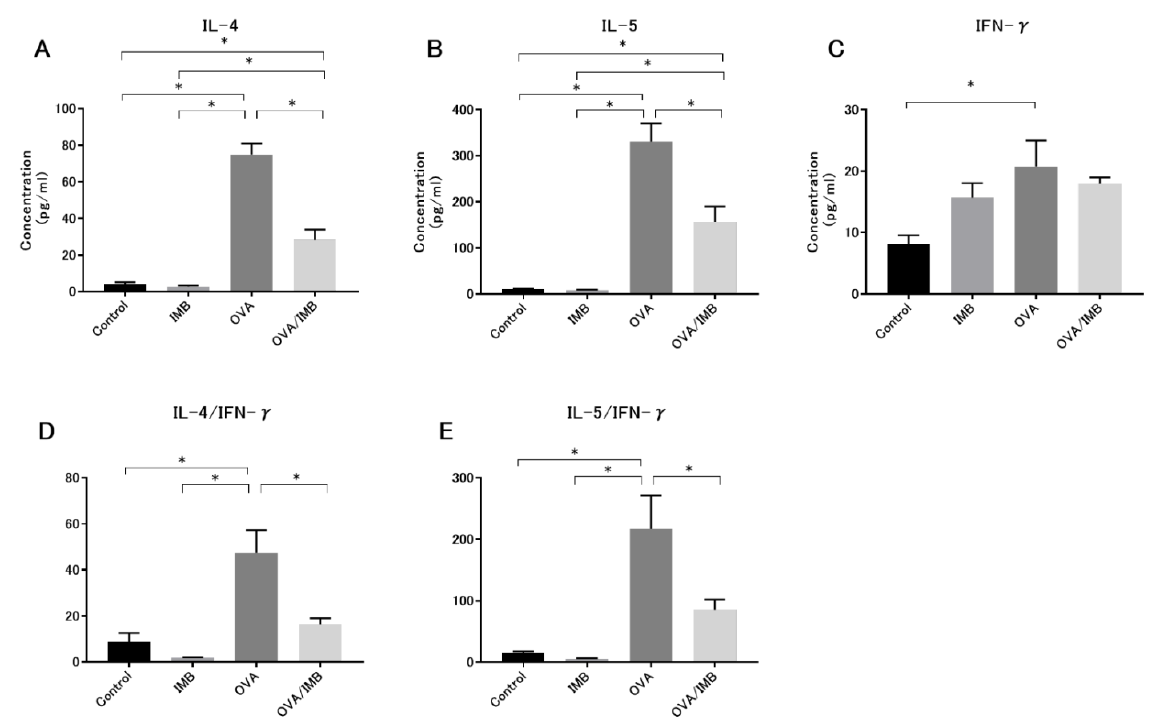
Figure 5. The levels of cytokines in BALF. The levels of IL-4 and IL-5, the ratio of Th2 to Th1 cytokines were significantly attenuated by ImmuBalance treatment ( A , B , D , E ), but no significant change was observed in the levels of IFN-γ ( C ). Values represent the mean ± standard error of the mean. * p < 0.05.